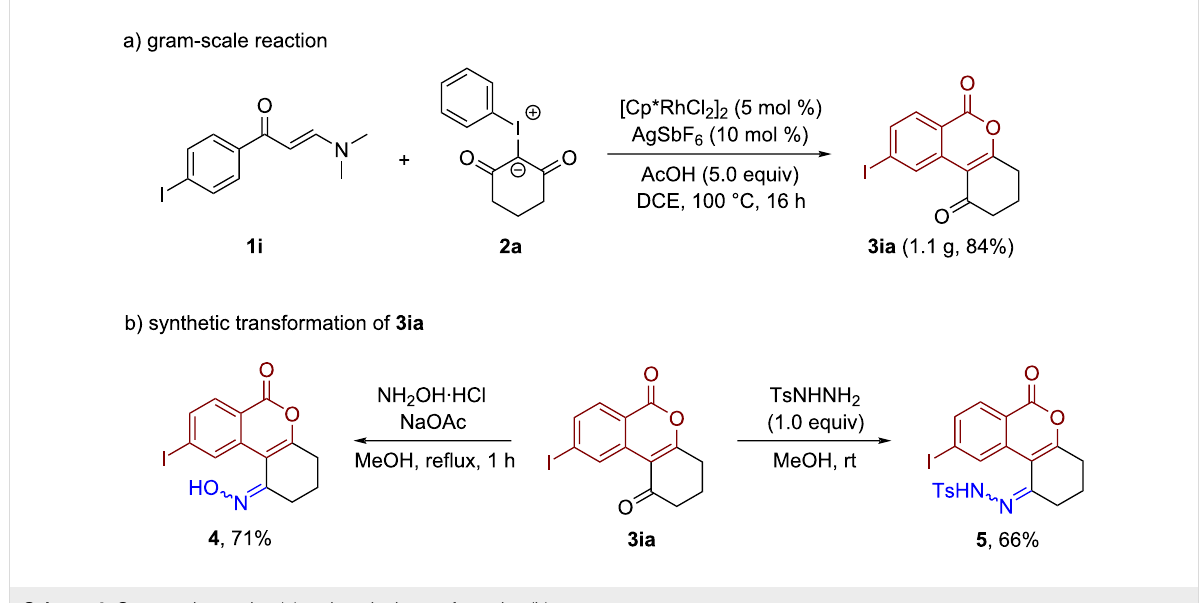
Scheme 4: Gram-scale reaction (a) and synthetic transformation (b).